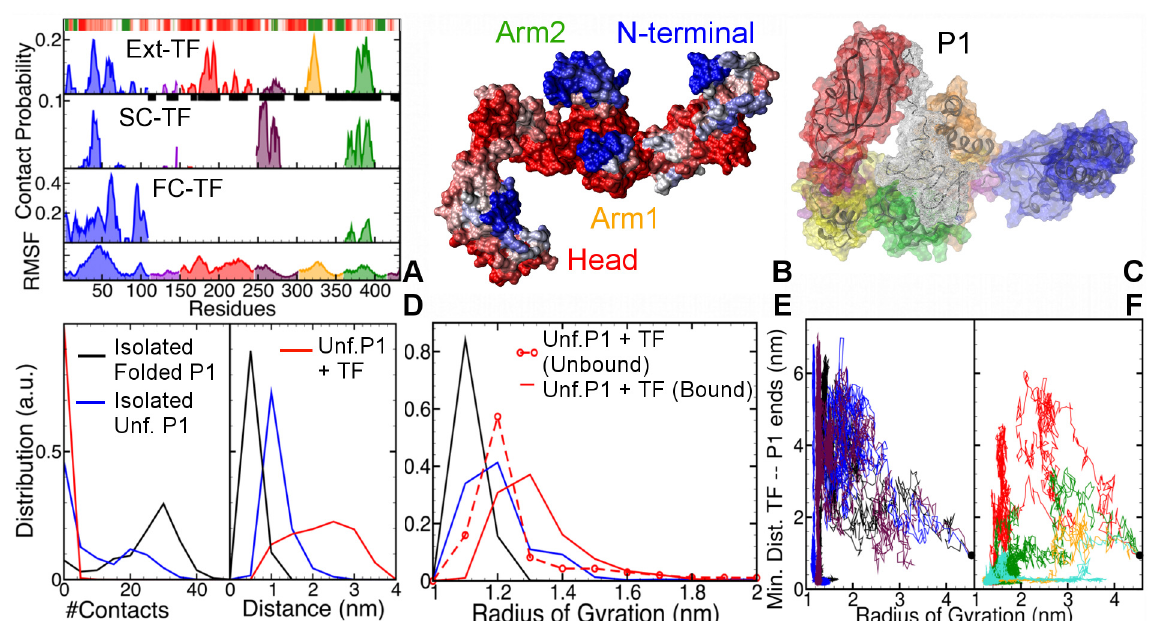
Fig 2. A. Contact probabilities of the residues of the extended (Ext), semi-collapsed (SC) and fully collapsed (FC) conformations TF with unfolded P1. The bottom-most panel plots the root mean squared fluctuations of TF ’ s residues, with peaks indicative of flexible regions. Colors refer to the different TF domains: N-terminal in blue, Linker in violet, PPIase domain in red, HA1-linker in maroon, Arm1 in orange, and Arm2 in green. The black squares on the residue (x-) axis of the extended TF plot shows the interaction sites identified by Saio, et al . [14]. B. Visualization of the most likely interaction sites (blue) on TF ’ s surface. C. Final TF-P1 complex obtained from one of the simulations, with shown in transparent white colored wire-mesh. D. Distribution of end-to-end contacts (left panel), and COM distance between the first and last 5 residues (right panel) in P1. E. Distributions of the radius of gyration of P1. F. 2-D plots of minimum distance between TF and P1 ’ s ends against radius of gyration of unfolded P1, when: P1 collapses before the contact formation (left panel) and after contact formation (right panel) with the P1 ’ s